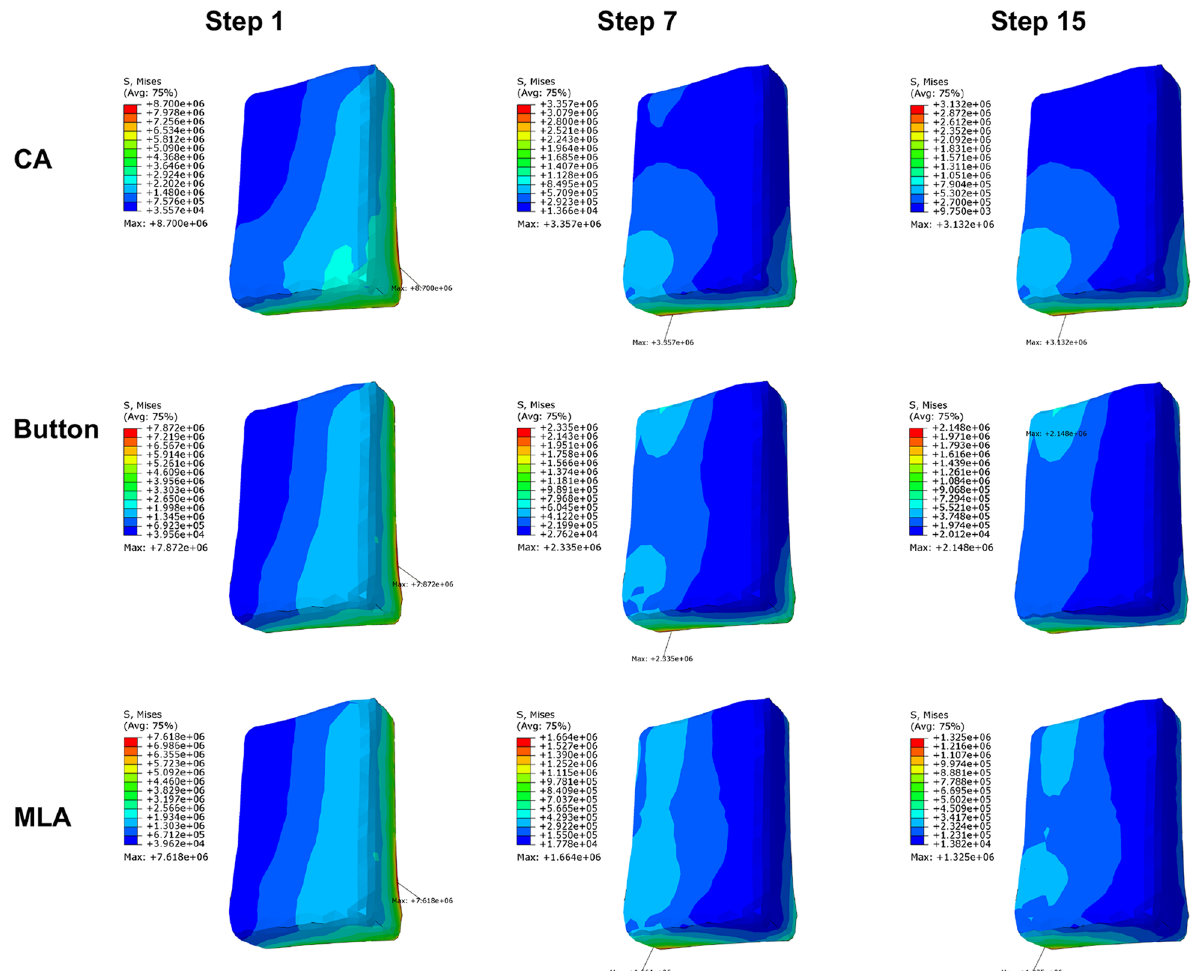
Fig. 5 Von Mises stress (Pa) of attachments at the beginning, intermediate, and final